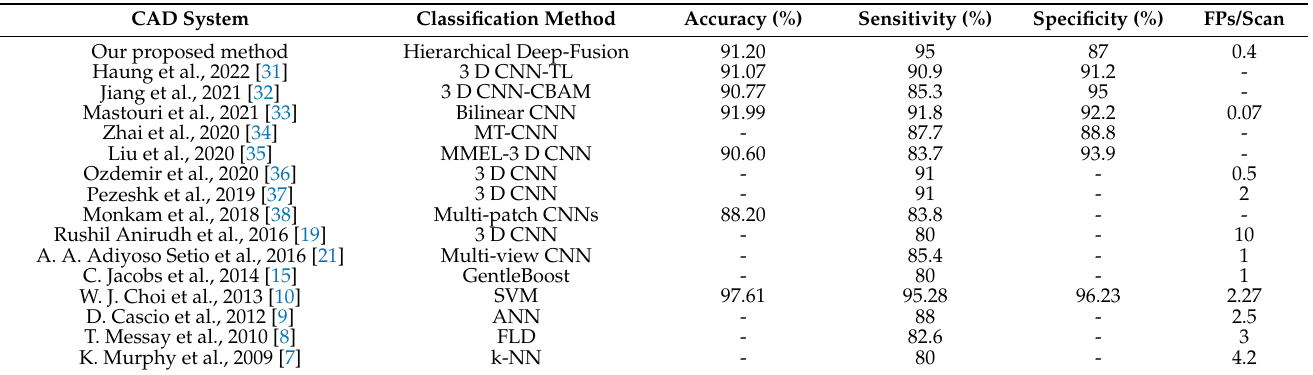
Table 1. Comparison of the proposed hierarchical scheme with the relevant